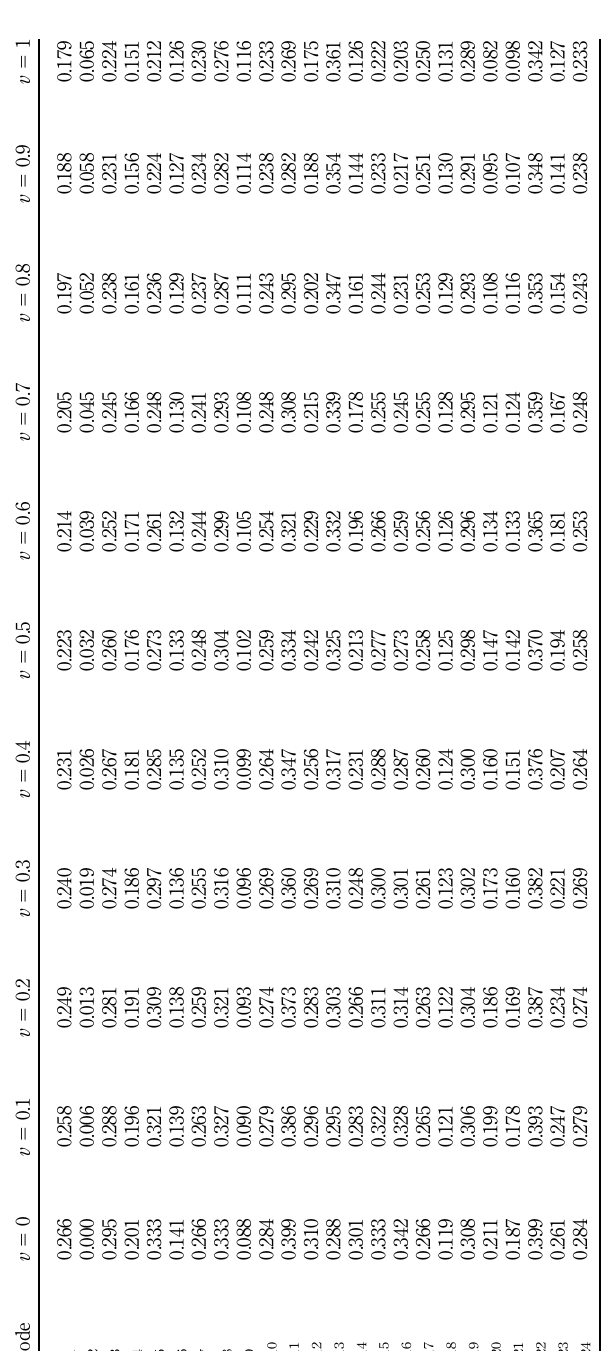
Table 9. The Q i values